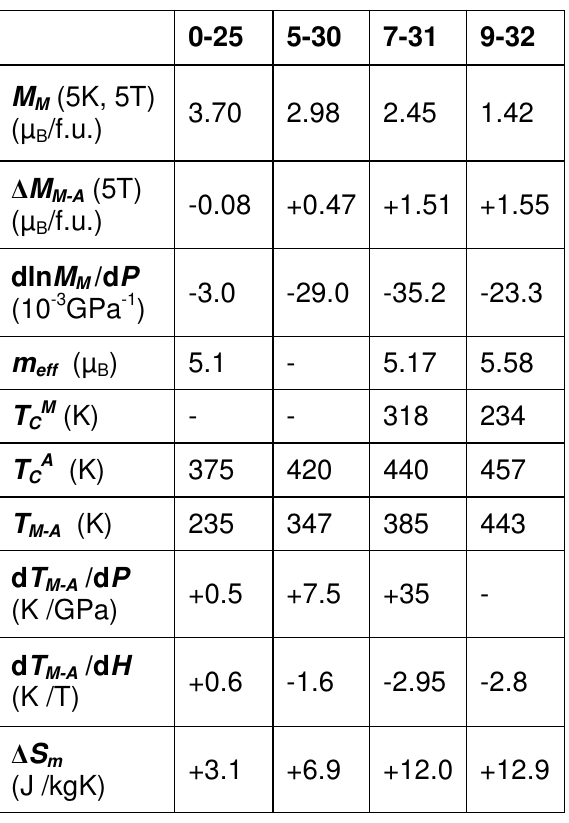
Table 1. The values of magnetization M M , its change  M M-A and its pressure derivation, effective paramagnetic moment m eff , transition temperature T M-A of noticed samples with its pressure and field dependence that was used to a determination of  S m